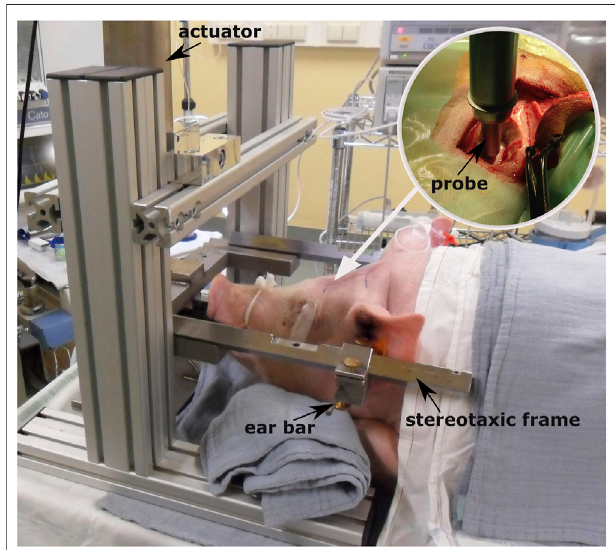
FIGURE 1 | Controlled cortical impact setup [adapted from De Kegel (2018)]andpositioningoftheanimalpriortotesting.Thewhitearrowindicates the point where the craniotomy is performed after sedating the animal. The circular image on the top right corner illustrates how the probe is mounted on the electromagnetically driven actuator and is placed over the closed dura mater before the impact.